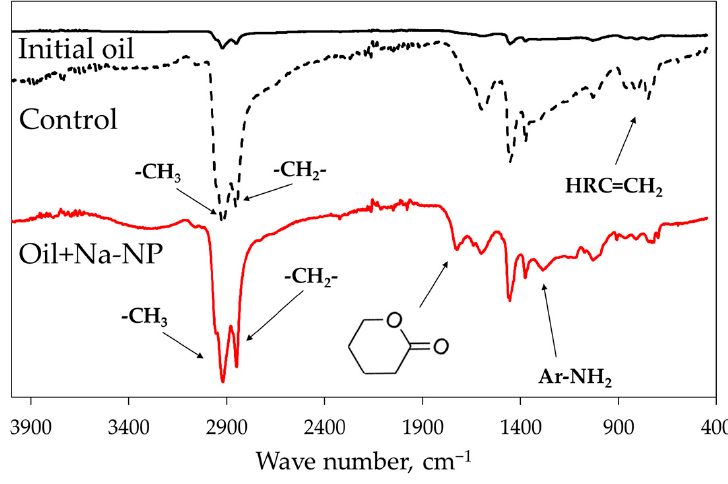
Figure 4. IR spectra of asphaltenes oil before and after processing.